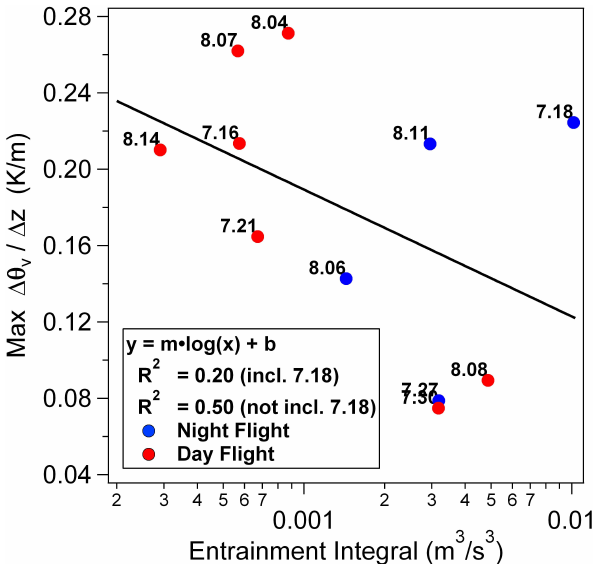
Fig. 12. Scatter plot of the boundary layer integral (i.e. R + F b from Eq. 6) versus the maximum θ v gradient, which is a measure of the stable stratification of the air in the cloud top region. Each point is the average value for the flight, with the corresponding date beside each point, and color denoting day and night